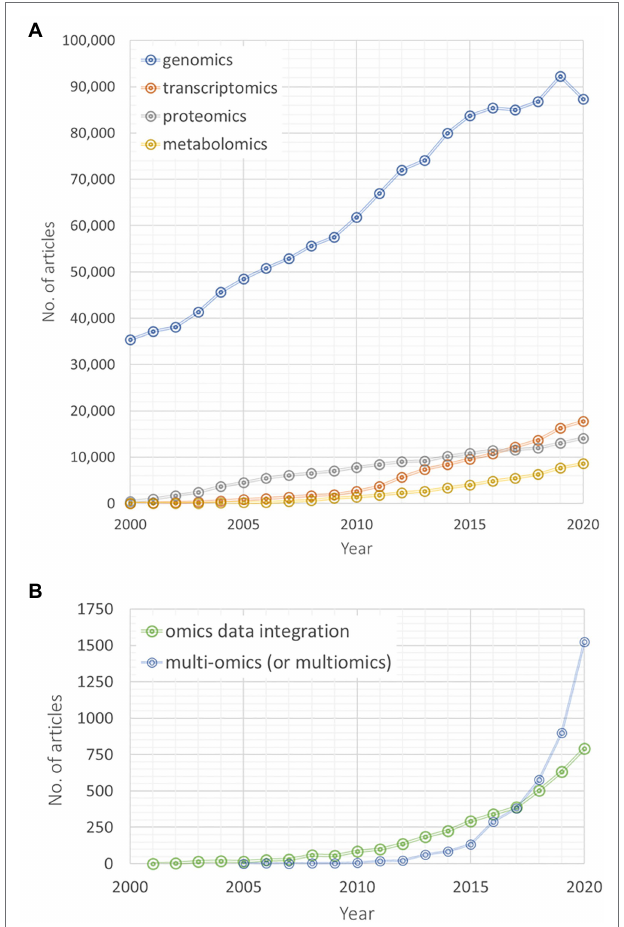
FIGURE 1 | Number of articles found by article search in the PubMed® library covering 2 decades, i.e., 2000–2020 (https://pubmed.ncbi.nlm.nih.gov). (A) Timeline of number of articles on different omics disciplines (blue: genomics; orange: transcriptomics; gray: proteomics; and yellow: metabolomics). Articles were searched by single key word search, (B) Timeline of number of articles found by search on omics data integration (green line; single words were connected by AND-expression) and multi- omics (or multiomics, blue